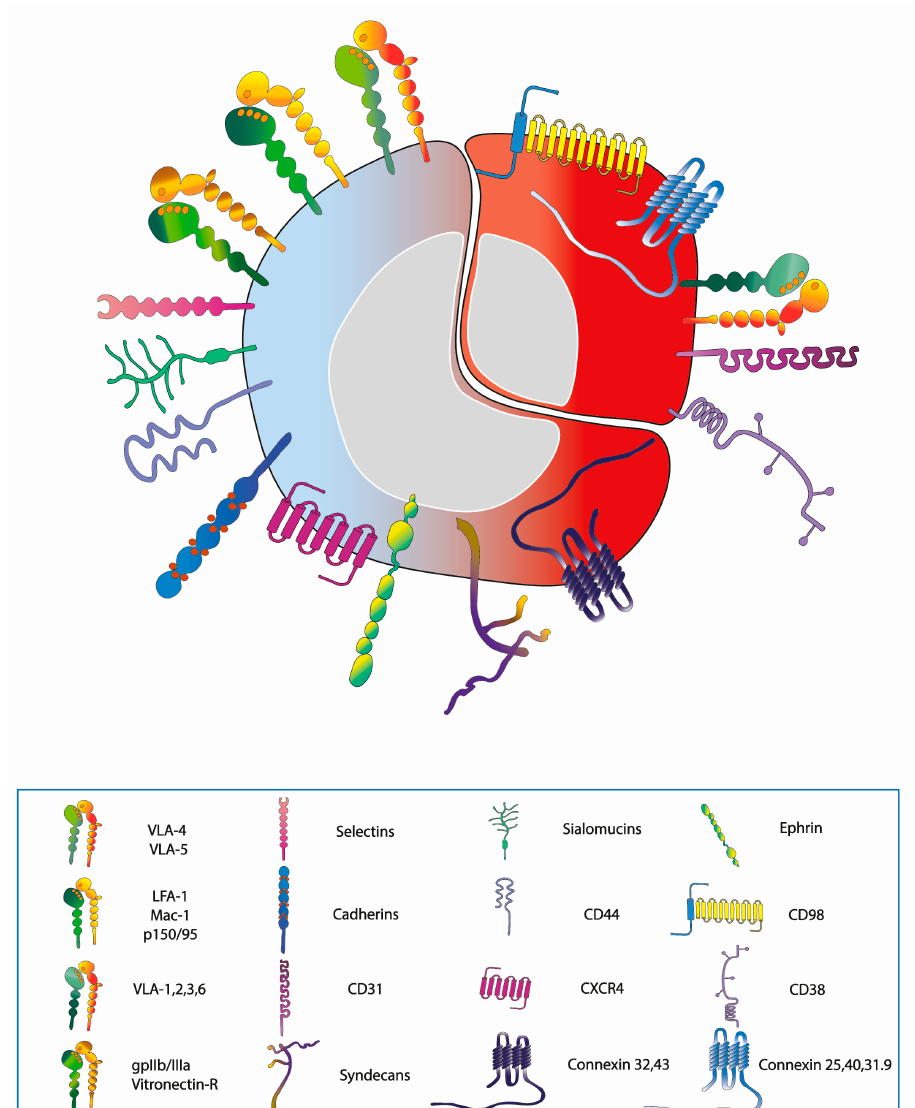
Figure 1. Expression pattern of AMs, chemokine receptors and other adhesion-modulating proteins on the surface of HSC and LSC. The molecules in common are depicted on the blue-red cell (left to lower right), while the molecules expressed exclusively on LSC are drawn on the surface of the red cell (upper right).